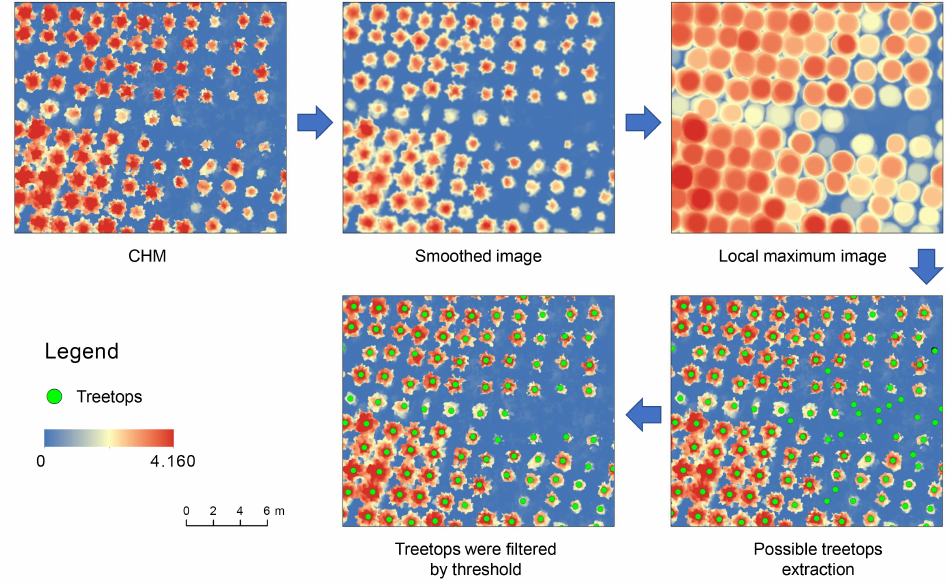
Figure 2. Overview of the workflow for individual tree crown detection using local maxima (LM) algorithm (using CHM as an